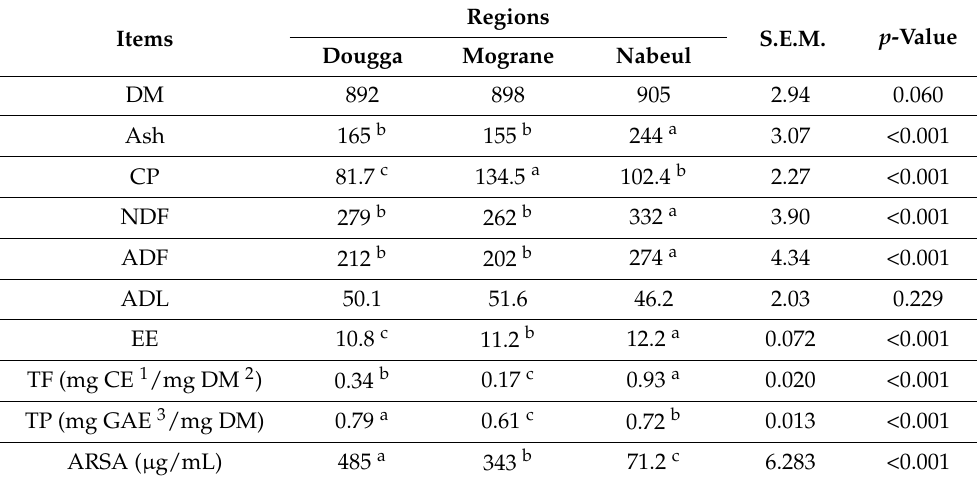
Table 1. Chemical composition, active phytochemicals (g/kg dry matter), and anti-radical scavenging activity ( µ g/mL) of A. iva leaves cultivated in three different Tunisian regions. Regions Items S.E.M. p -Value Dougga Mograne Nabeul DM 892 898 905 2.94 0.060 Ash 165 b 155 b 244 a 3.07 <0.001 CP 81.7 c 134.5 a 102.4 b 2.27 <0.001 NDF 279 b <0.001 ADF 212 b 274 a <0.001 0.229 EE 10.8 c 0.072 <0.001 TF (mg CE 1 /mg DM 2 ) 0.34 b <0.001 TP (mg GAE 3 /mg DM) <0.001